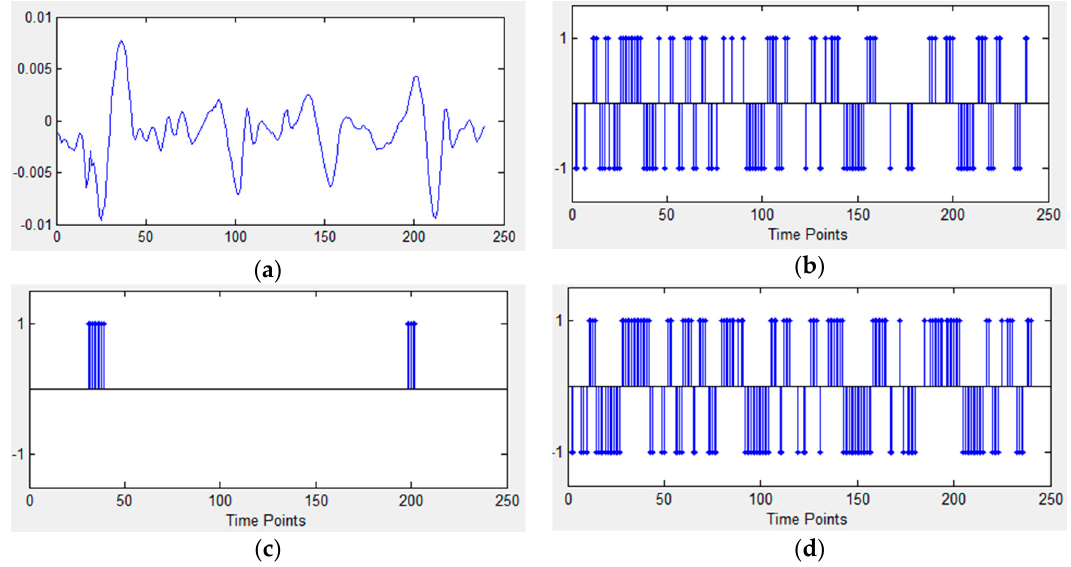
Figure 2. Spike trains generated by three different coding schemes. ( a ) Data stream of a channel; ( b ) Encoding with Address Event Representation (AER); ( c ) Encoding with Bens Spike Algorithm (BSA); ( d ) Encoding with Step Forward (SF). Note that spikes in ( b ), ( d ) are positive or negative but there are only positive spikes in ( c